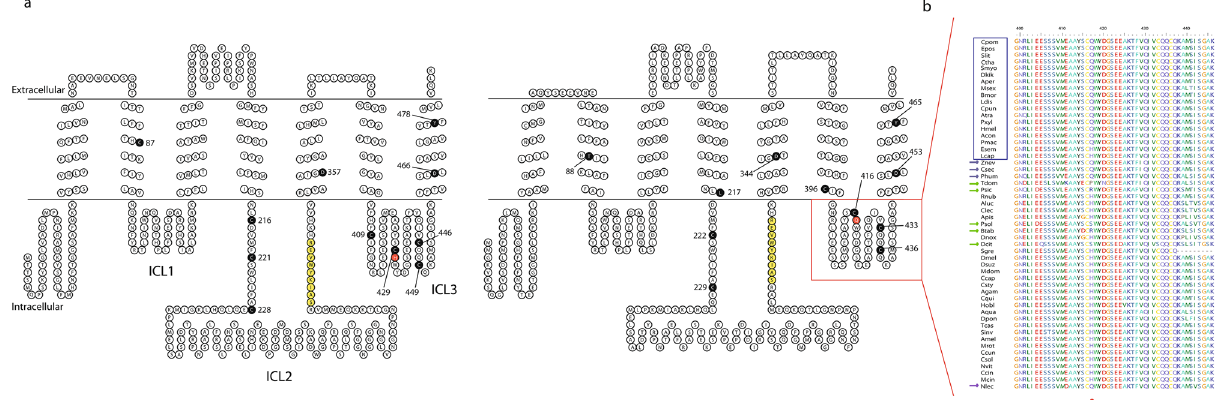
Figure 1. Analysis of the Orco polypeptide sequence: topology and ICL-3. ( a )—topological representation of Orco, between D. melanogaster (left) and C. pomonella (right). Numbered black residues: amino acids with possible influences for DmelOrco VUAA-binding and sensitivity [cysteines, Turner et al. 37 ; aspartates 357 and 466 36 , the respective position on DmelOrco related to the B. mori tyrosine 464 38 , for which mutagenization alters current–voltage relationships, and Potassium selectivity (tyrosine 478), and their respective positions on CpomOrco (right)]. Yellow residues: Calmodulin binding sites (“SAIKYWVER” 50 ). Red residues: ICL-3 histidine (left) and the respective substitution on CpomOrco (Q, right). Red square: ICL-3 alignment based on Topcons predictions of Dmel- and CpomOrco. ( b )—sequence alignment of the ICL-3 of Orco amino acid sequences among insects of the Supplementary Dataset file. Acronyms for insect names are given based on Table 1. Blue square: Lepidopterans; blue arrows: non-Lepidopterans insects provided with the H-Q substitution; green arrows: non-Lepidopteran insects provided with other types of substitutions at the H417 position (red asterisk). Numbers on the top: positions of amino acid residues based on the polypeptide sequence of